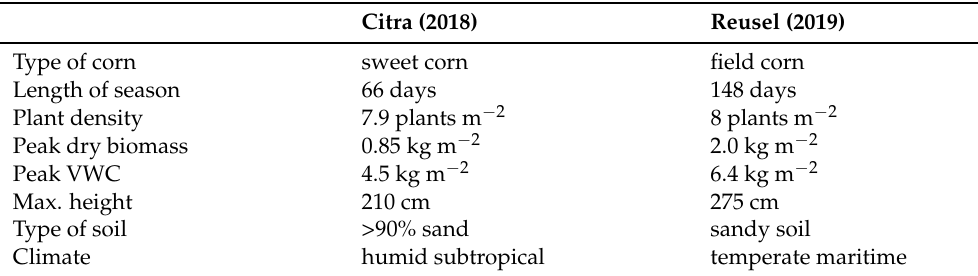
Table 1. Details of the experimental sites. Measurements from Reusel, the Netherlands (2019), were used for examining sub-daily variations in the vertical distribution of VWC only. For all other analyses, we used data from Citra, Florida